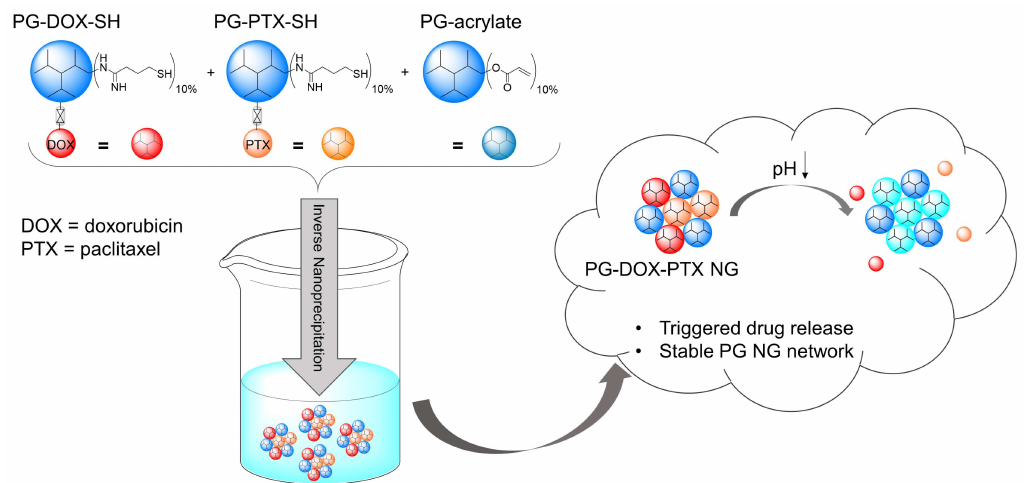
Figure 1. Preparation of multidrug PG NGs by an inverse nanoprecipitation method and their behavior in acidic pH. PG–drug conjugates were functionalized with approximately 10% free thiol groups (SH) in order to react with 10% acryl groups on the macro crosslinker